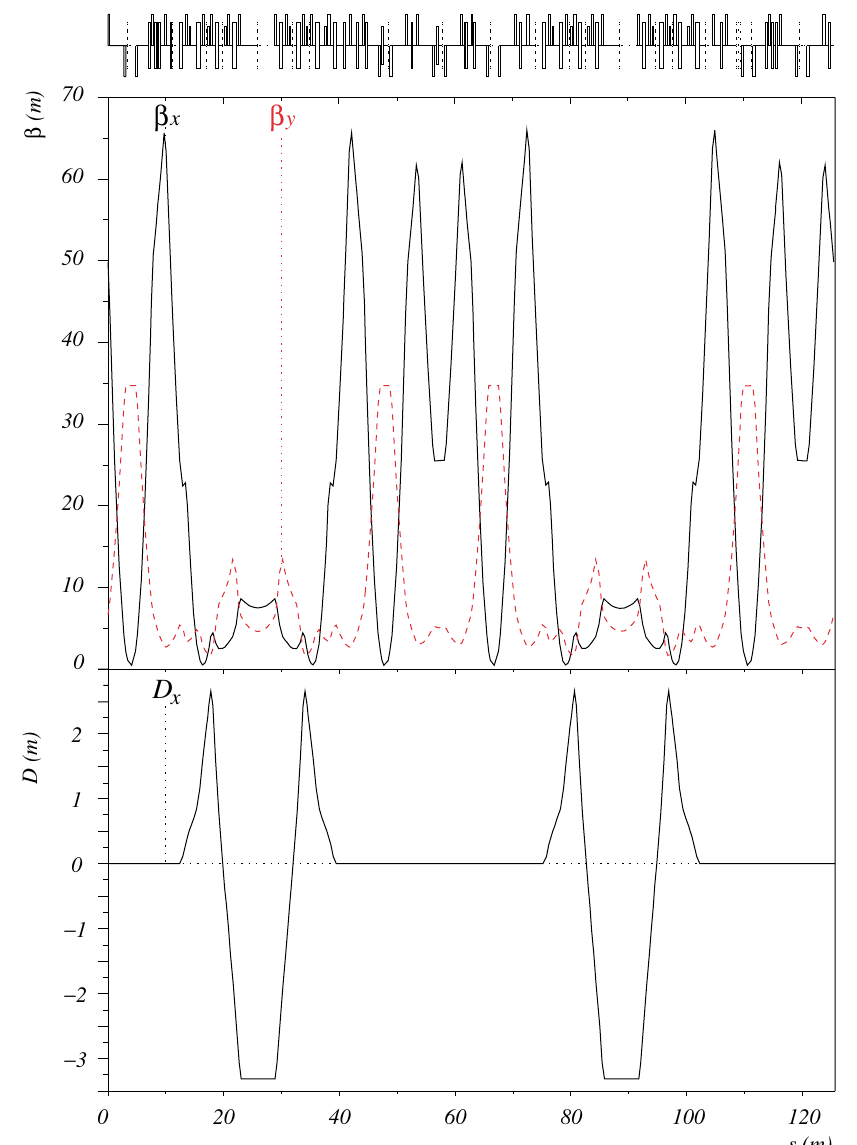
FIG. 8. (Color) Design optics of the isochronous combiner ring starting from the injection point. The top graph shows the horizontal (solid line) and vertical (dashed line) (cid:5) functions, the bottom graph the design horizontal dispersion function. The vertical dispersion is